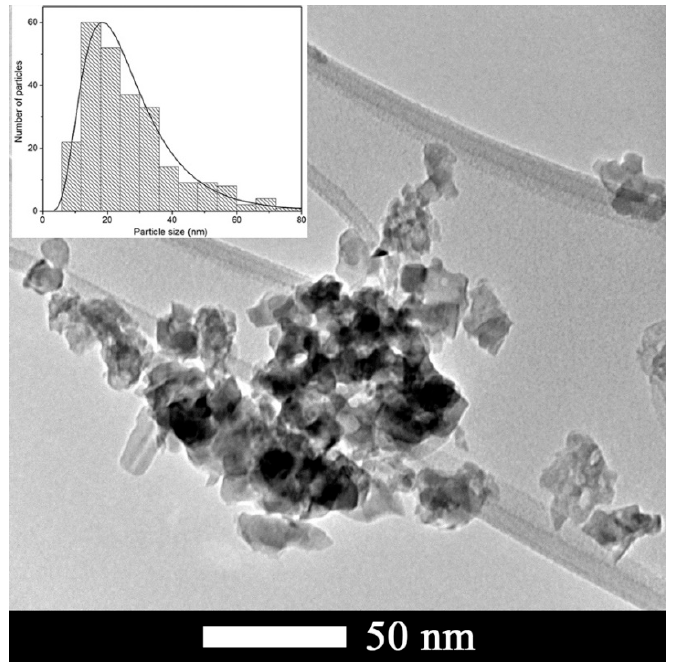
Figure 4. TEM image of CTO nanoparticles. Inset: Particle size distribution of 253 nanoparticles obtained from 26 TEM different images.